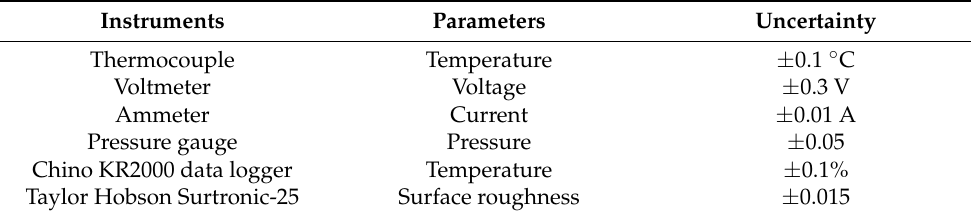
Table 2. Uncertainty of the instruments. Instruments Parameters